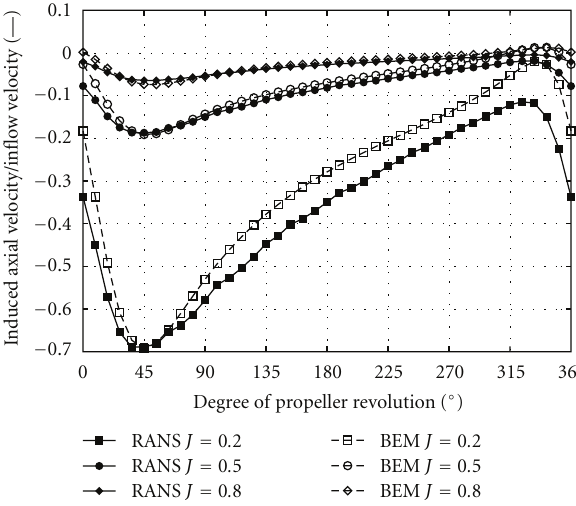
Figure 8: Comparison of the normalised induced axial velocities for di ff erent time-step sizes (explicit coupling: r/R = 0 . 7, J = 0 . 5, and dx = 0 . 5 R ).